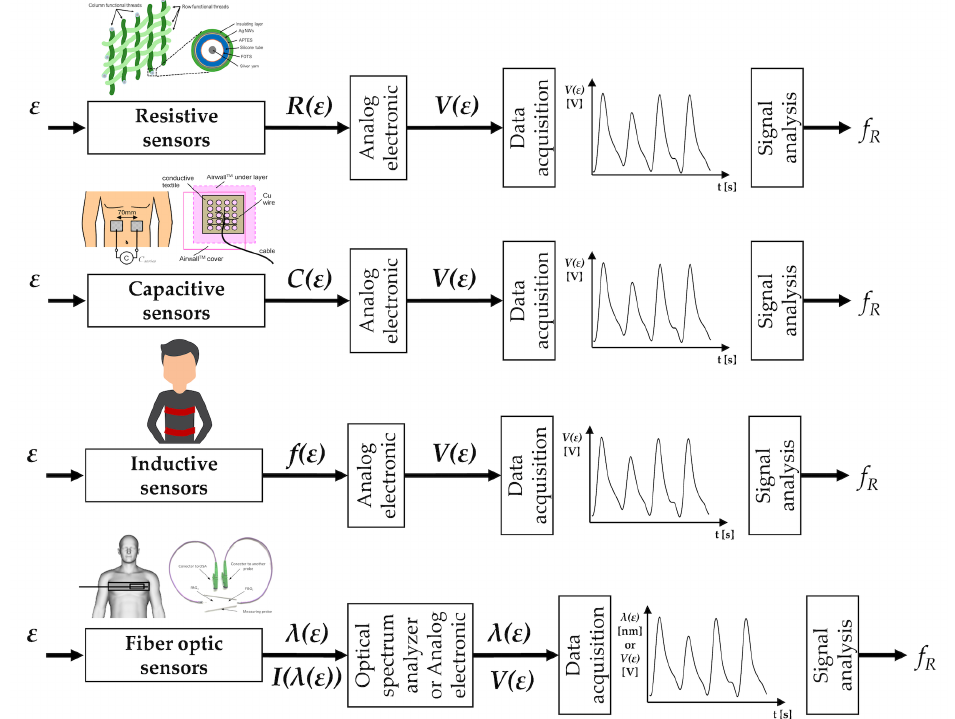
Figure 7. Strain sensors: the main elements composing the measuring chain (sensor, analog electronics, data acquisition, post-processing or signal analysis stage) to estimate f R . Analog electronic stages vary between different sensors since the output quantities are different. R ( (cid:101) ) , C ( (cid:101) ) , f ( (cid:101) ) , λ ( (cid:101) ) , I ( λ ( (cid:101) )) are resistance, capacitance, frequency peak, wavelength and light intensity changes caused by the strain ( (cid:101) ), respectively. V ( (cid:101) ) is the voltage output. The resistive sensors picture is from [158]; the capacitive sensor picture is adapted from [159]; the fiber-optic sensors picture is adapted from